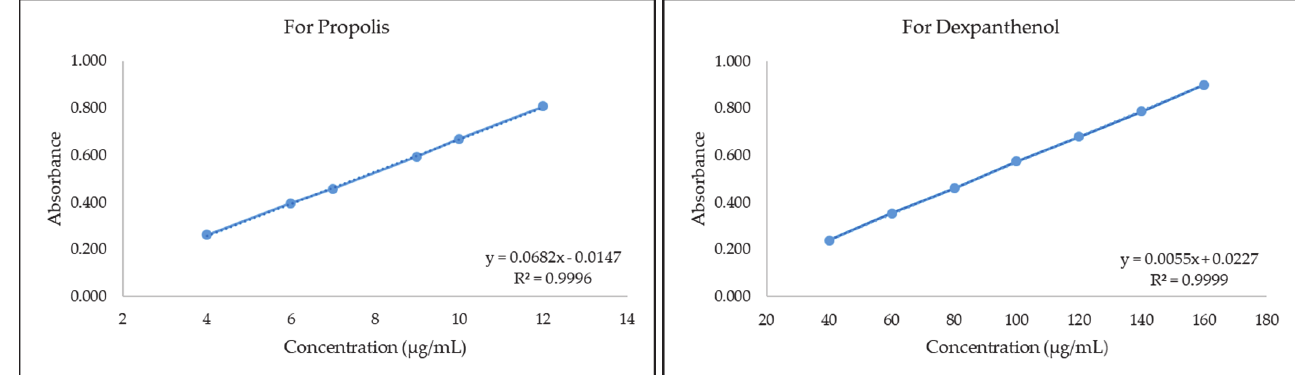
Figure 1. Calibration curves and equations of propolis and dexpanthenol.